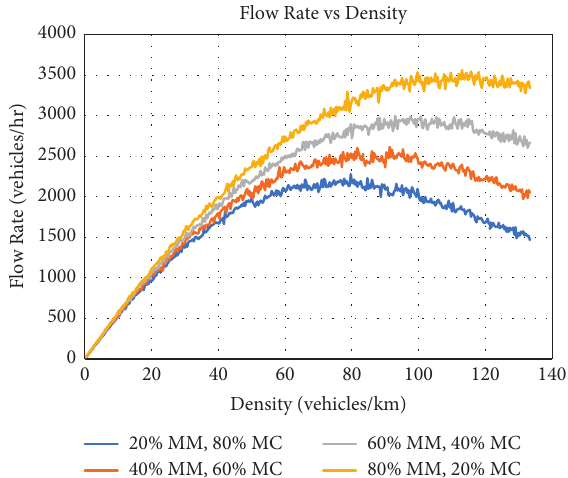
Figure 37: Flow rate vs. density fundamental diagrams for different compositions of MM and MC.